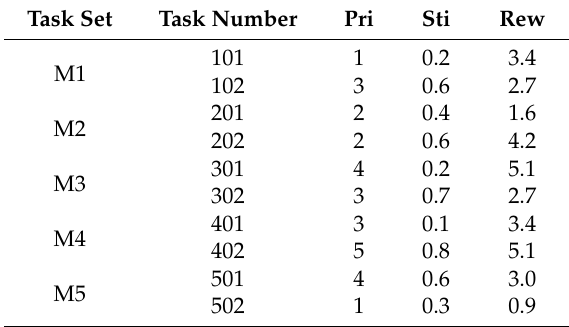
Table 1. Part task parameter setting information.